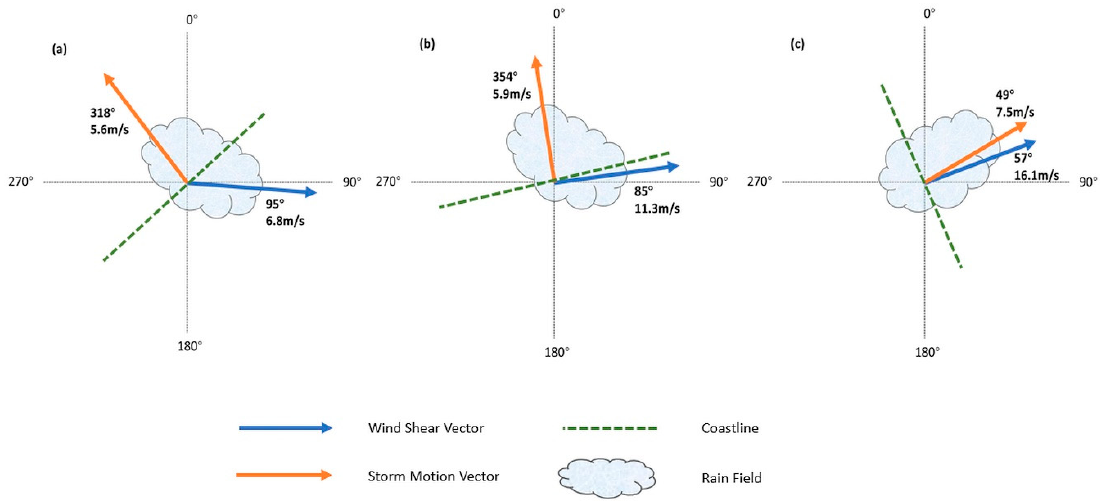
Figure 12. The averaged storm motion and wind shear vectors by regional groups (( a ): western group; ( b ): central group; ( c ): eastern group). The shaded region is where rainfall should occur according to the combined vectors and storm’s counterclockwise rotation.